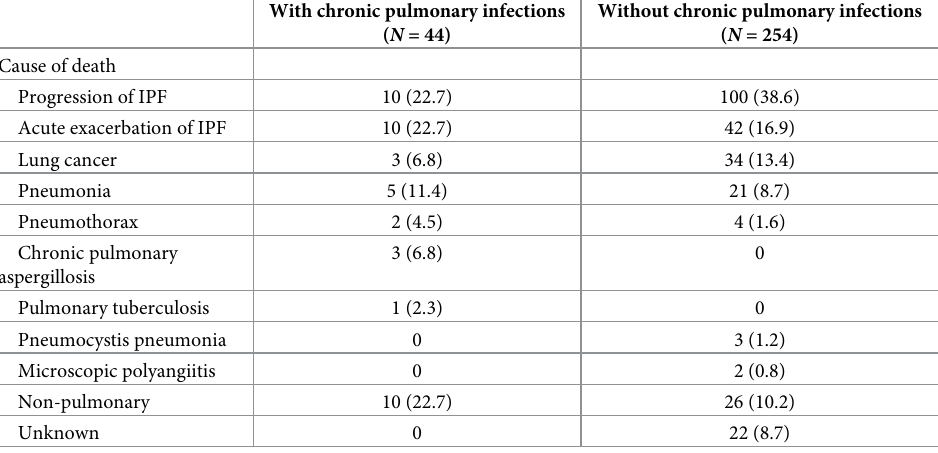
Table 4. Causes of death in patients with idiopathic pulmonary fibrosis (IPF) with or without chronic pulmonary